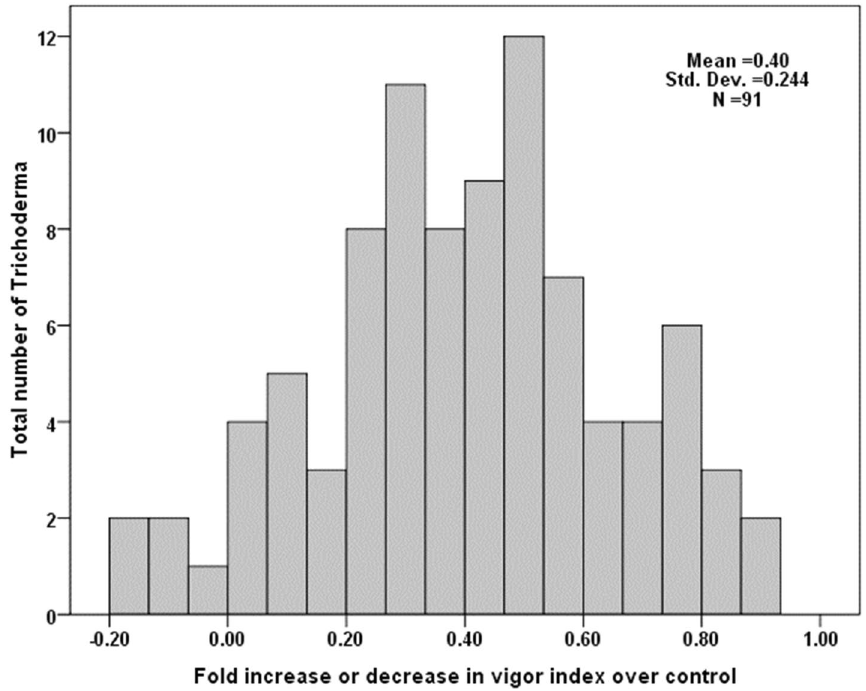
Figure 6. Fold changes in vigor index of pearl millet seedlings over control upon seed treatment with different Trichoderma